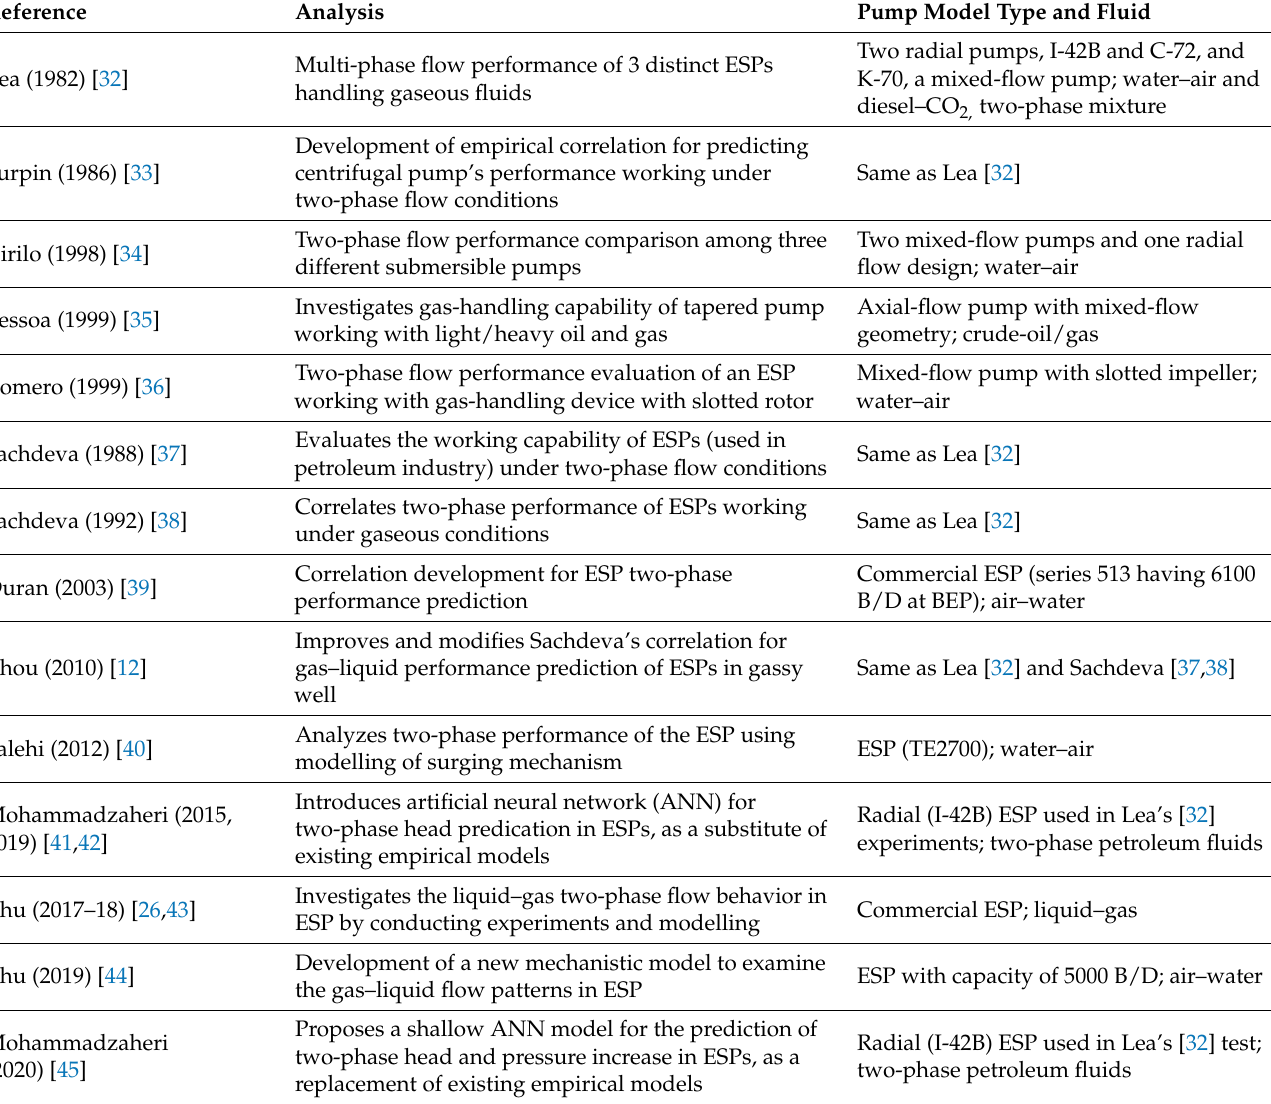
Table 1. Experimental analysis on ESP gas-handling performance based on empirical